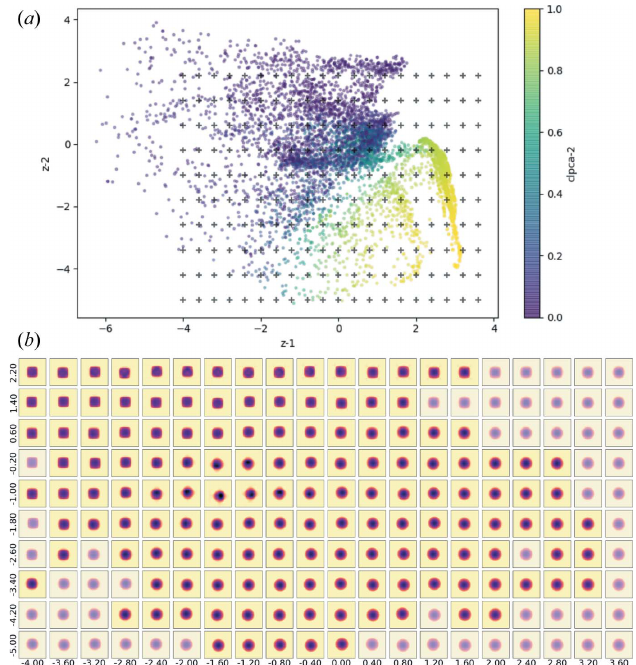
Figure 6 ( a ) The distribution of the dataset in 2D latent space, colour coded by CLPCA-2. Black crosses in the plot are the 200 selected latent numbers z . ( b ) The h 100 i direction projections of the 200 real-space densities retrieved from the logarithmic intensity volumes generated from the 200 selected latent numbers z [black crosses in panel ( a )]. Semi-transparent slices are volumes generated from latent regions with no or very few data